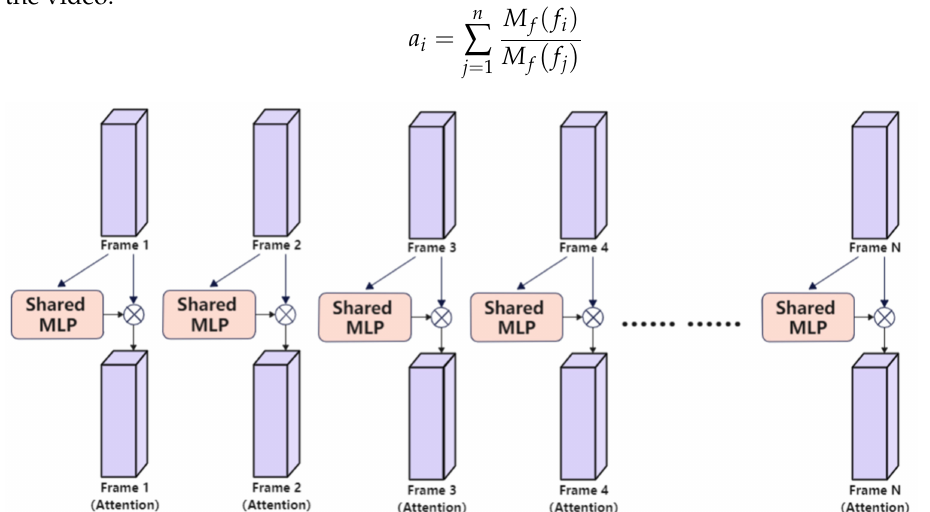
Figure 4. Schematic diagram of the fully connected network(FC) part of the baseline. In this part, the feature vectors output by the convolutional neural network are spliced together by frame to obtain the feature vector of the current video, and the final classification result is obtained through the MLP